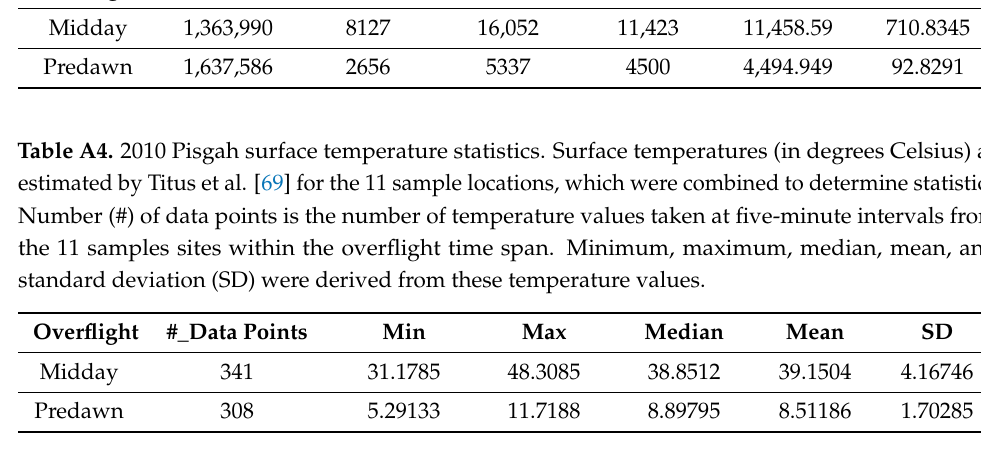
Table A5. Surface temperature (in degrees Celsius) and image DN range values from the 11 sample sites where surface temperature data were collected in 2010 [69,104]. Sample Site numbers (#) ranges from 1 to 11. Refer to Table A1 for flight times. DN gaps between midday minimum and predawn maximum DN levels are shown for comparison. Range